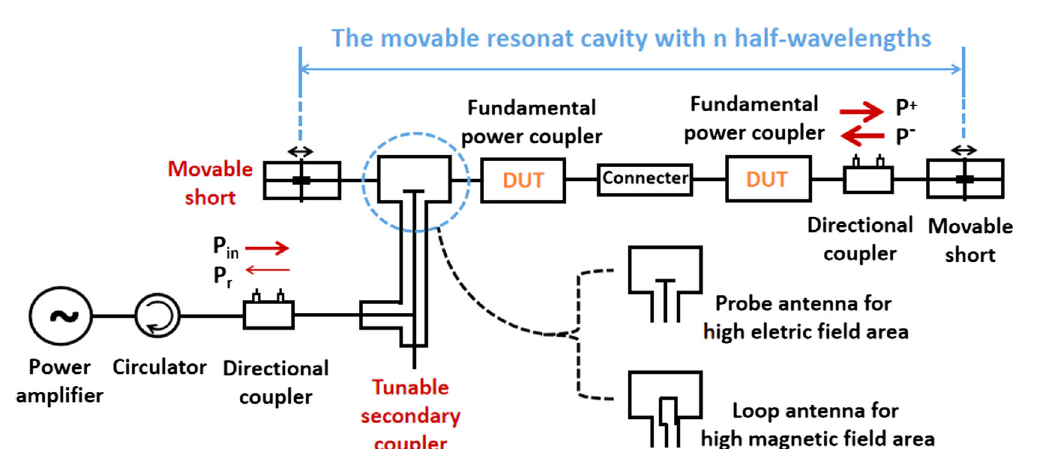
FIG. 1. Outline of the movable SW resonant test